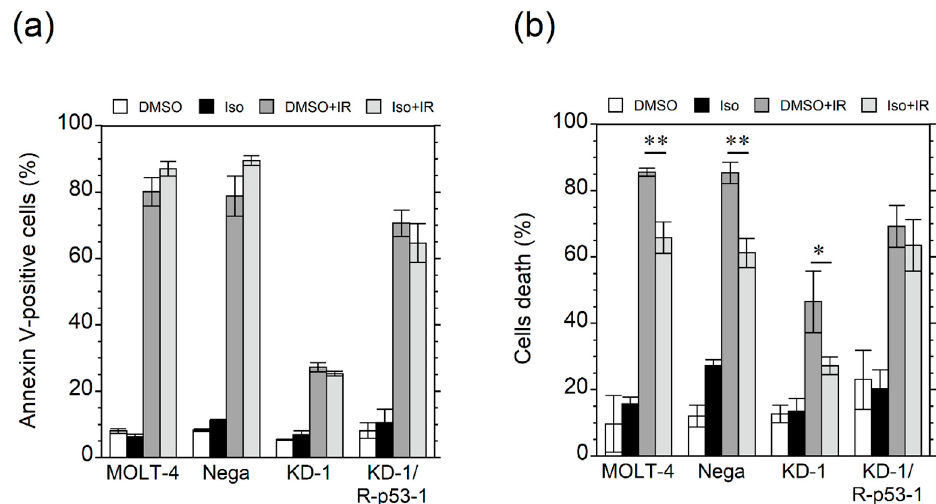
Figure 2. Isorhamnetin inhibits radiation cell death independent of p53 status and apoptosis. Cells were treated with 20 µ M isorhamnetin. ( a ) Apoptosis assay by Annexin V-FITC staining 20 h after 10 Gy irradiation ( n = 3). ( b ) Dye exclusion test 24 h after 10 Gy irradiation ( n = 3). Asterisks indicate a significant difference (* p < 0.05 and ** p < 0.01) between groups. DMSO dimethyl sulfoxide, Iso isorhamnetin, IR